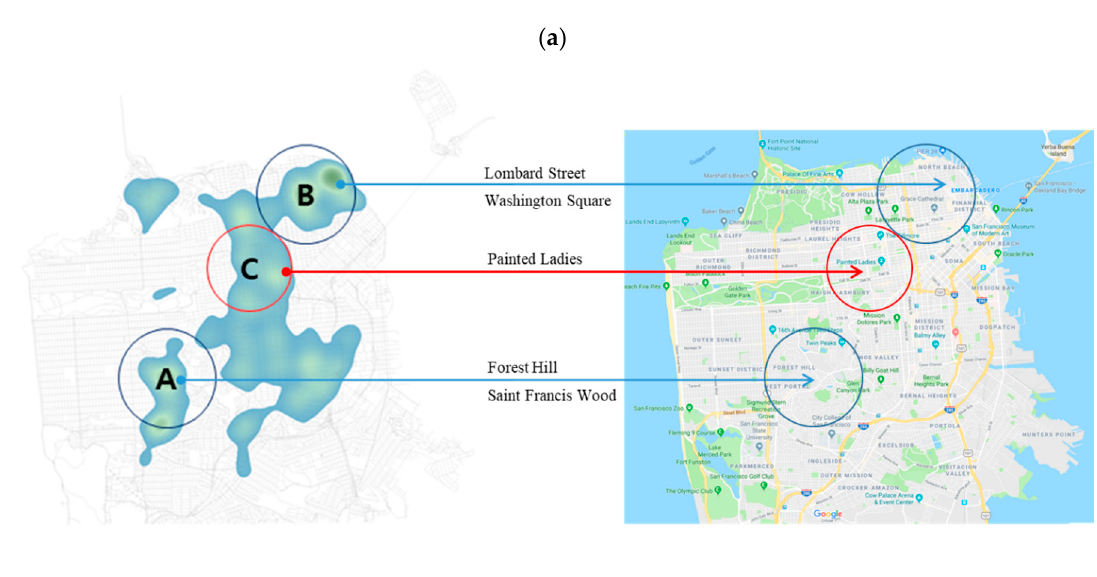
Figure 7. Locations on the maps of ( a ) New York and ( b ) San Francisco at the areas of A, B and C.